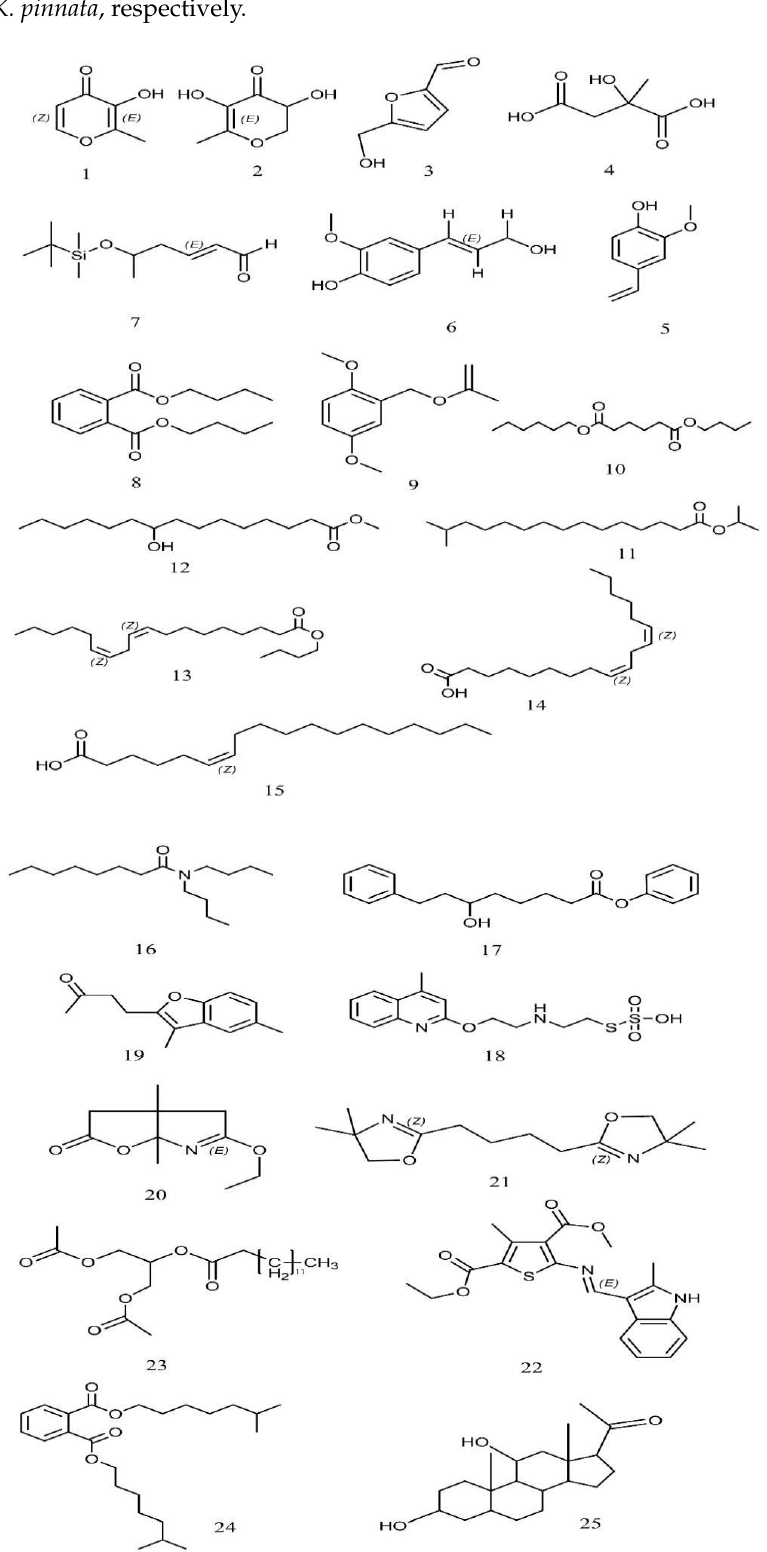
Figure 6. Structure of phytochemicals identified in methanol extracts of mature (K m ) fruits of K. pinnata .